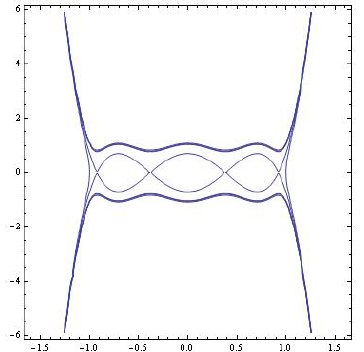
Figure 19. The level curves (the case a).